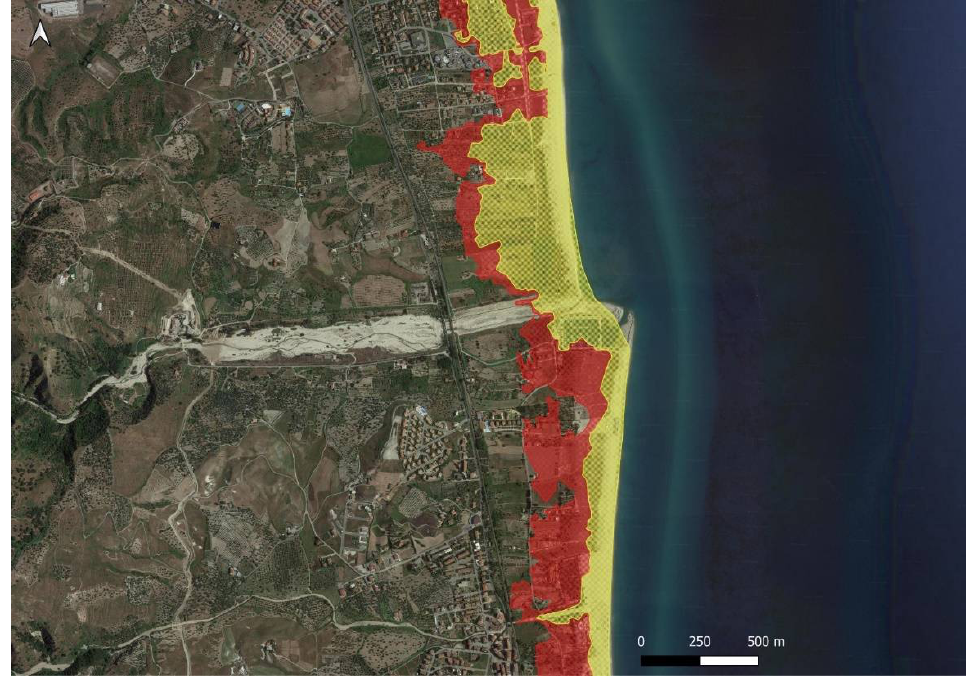
Figure 6. Badolato. Legend: Yellow, the floodable area in the current scenario; red, the floodable area in the future scenario.